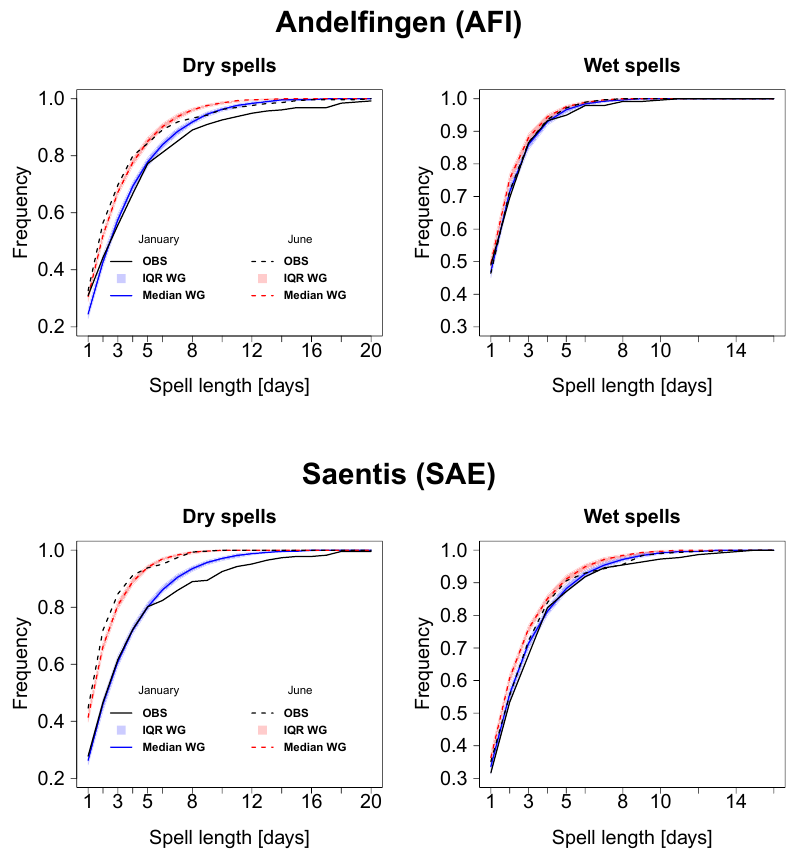
Figure 5. Cumulative distribution of the observed and simulated dry (left) and wet (right) spell length frequencies for lowland station Andelfingen (top) and mountain station Saentis (bottom). Results are for January and June during the time period of 1961–2011. The coloured area (line) represents the inter-quartile range (median) of the 100 realisations covering each 51year long daily time series.